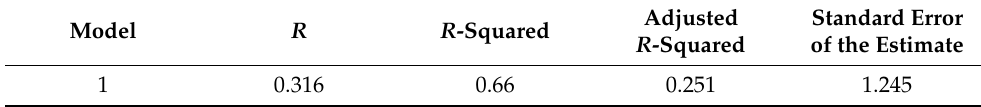
Table 7. Model summary for hypothesis